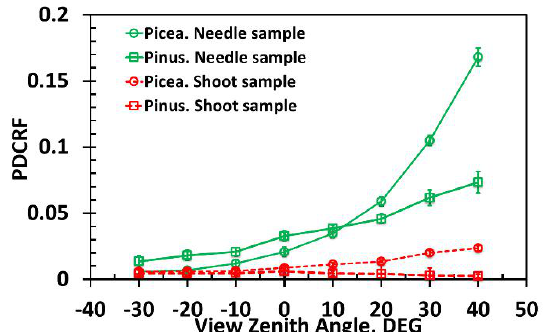
Figure 4. Angular distribution of average PDCRF of needle samples (solid lines) and shoot samples (dashed lines) averaged over 450–950 nm. Vertical bars denote standard deviation.